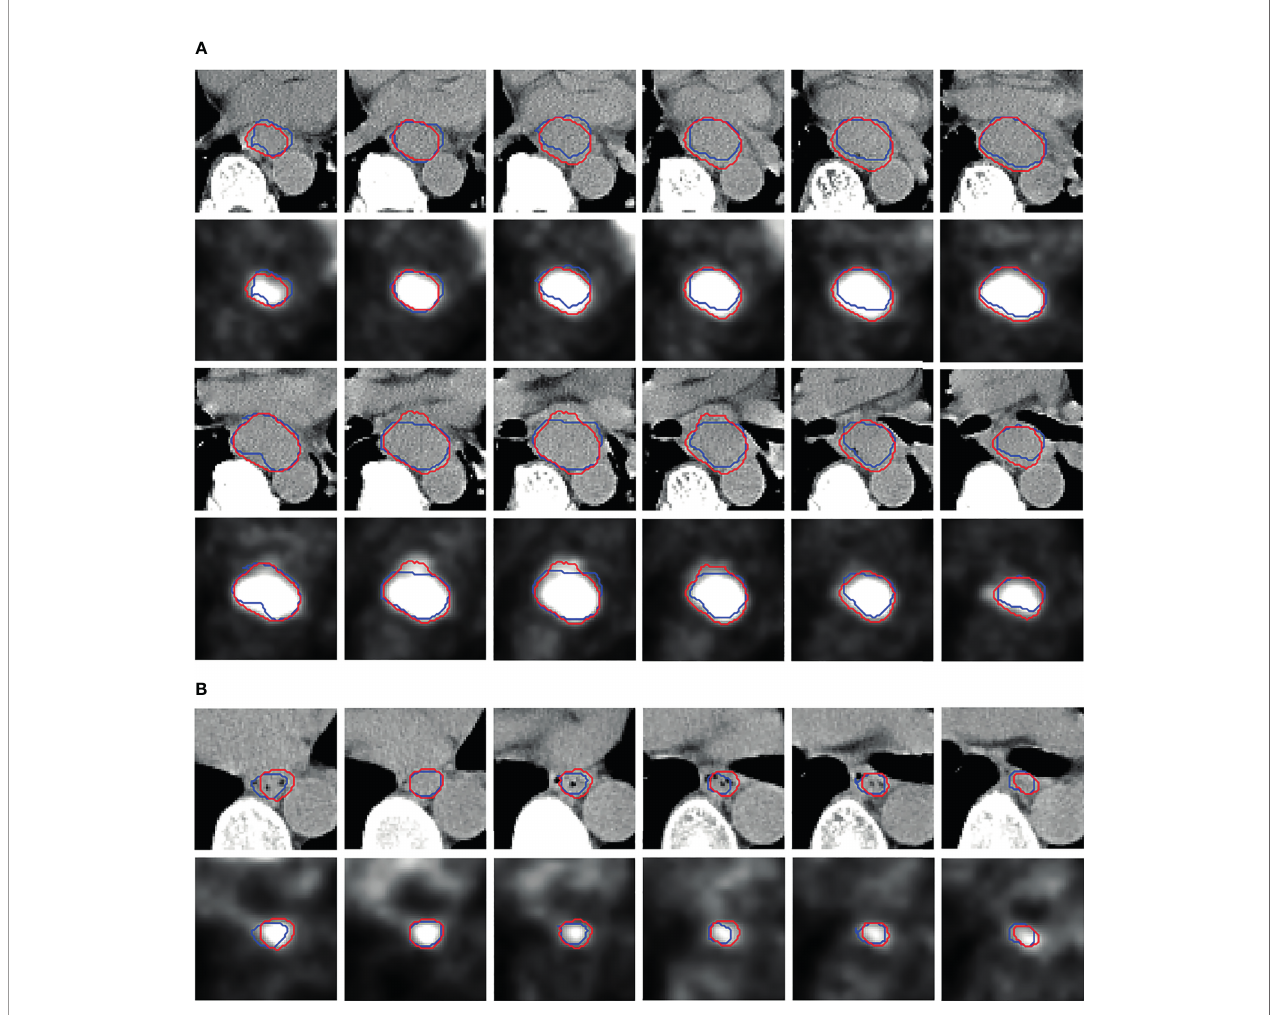
FIGURE 4 | Segmentation visual results. The more slices in patients (A) denote larger tumor than (B) . The red contours are the predicted results by PSNN, and the blue contours represent the ground